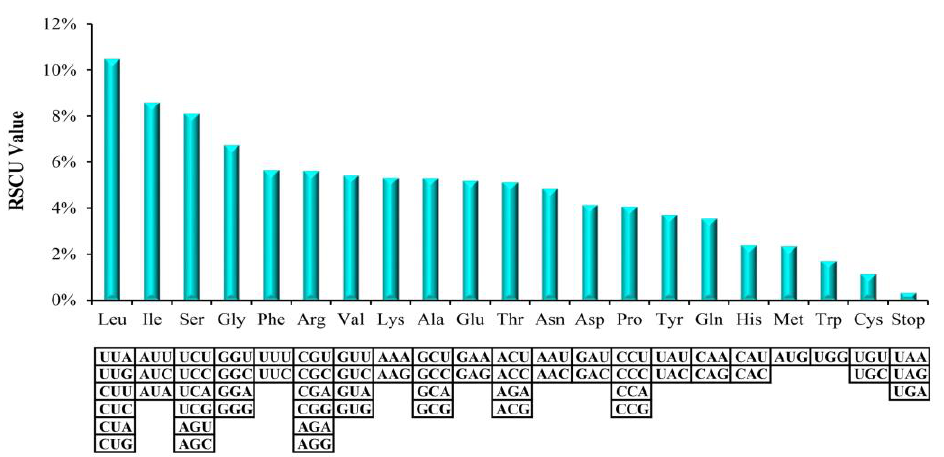
Figure 2. Codon content of 20 amino acid and the stop codon of 84 coding genes of the M. hupehensis cp genome.